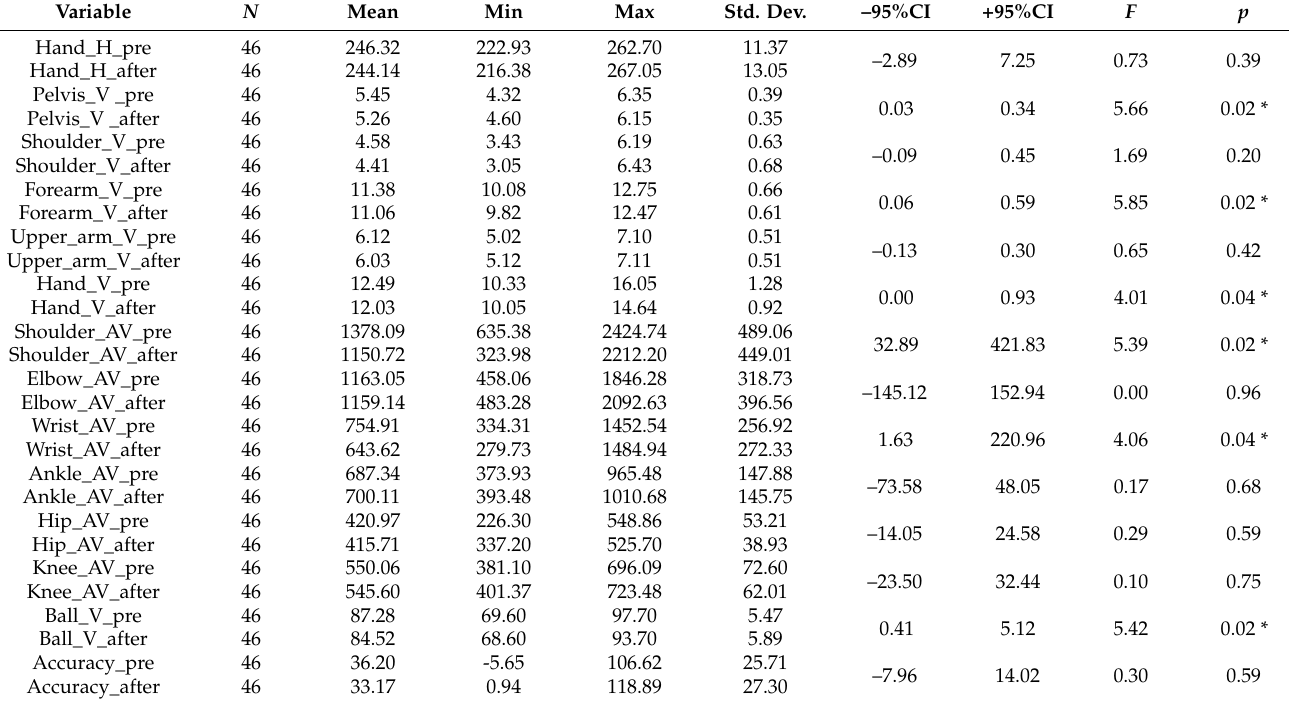
Table 3. Basic descriptive indicators and ANOVA results for repeated measurements before and after the fatigue protocol for the observed